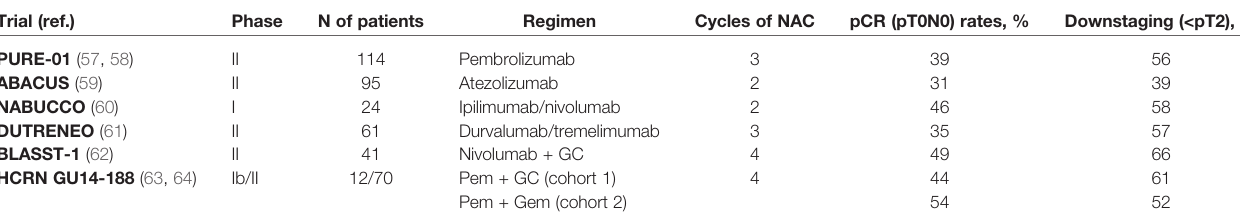
TABLE 3 | Main clinical trials of neoadjuvant immunotherapy for MIBC. Trial